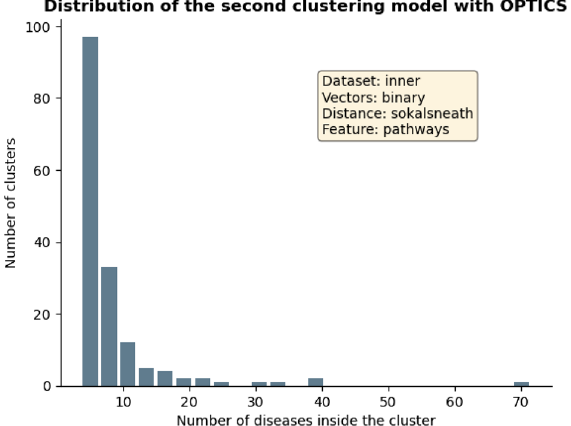
Figure 2. Distribution of the number of diseases in each cluster for the second analysed model obtained performing OPTICS. The model was generated from the inner dataset regarding pathways as the studied features, with binary vectors and computing distances with sokalsneath metric. The histogram bars were filtered so that clusters with less than 5 diseases are not displayed. The global results for this model were of 729 clusters, 1228 diseases as noise (from a total of 4130), a Silhouette score value of 0.43, a CH score value of 13.19 and DB score value of 1.12.